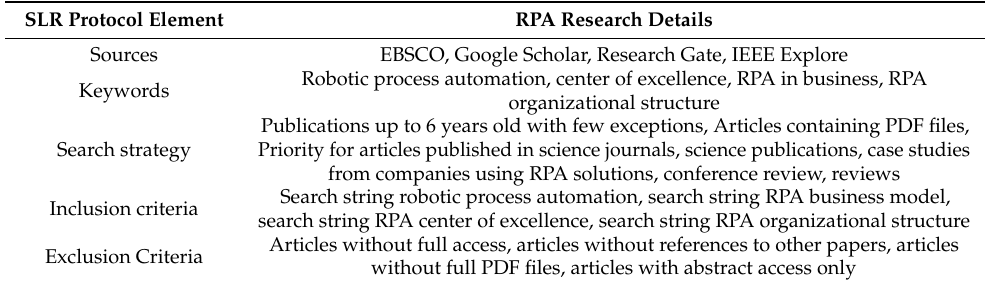
Table 2. Research details for RPA subject.